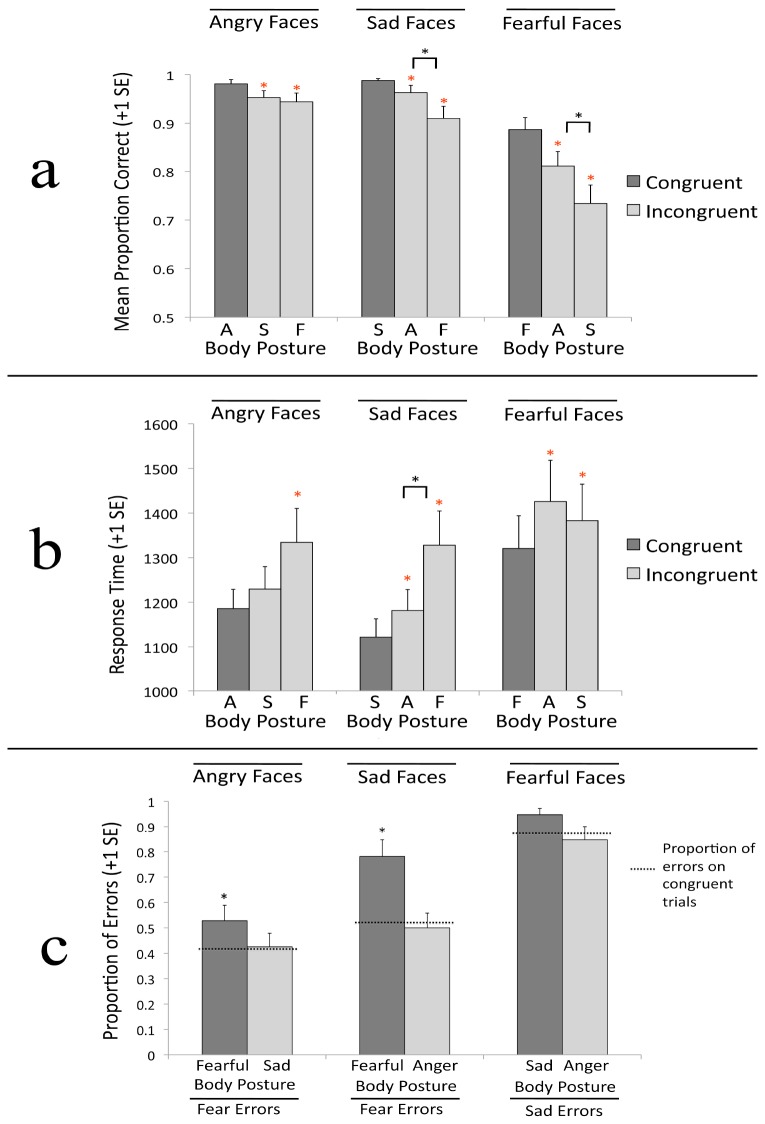
Results for Experiment 1a.a) Proportion of correct responses for each facial expression, presented by posture. b) Median reaction time results for each facial expression, presented by posture. Results are presented in milliseconds. c) Proportion of errors made for each facial expression, presented by posture. Dotted line represents the proportion of errors made by participants viewing congruent expressions, and was used as a baseline error level. * over individual bars indicate a significant difference between congruent and incongruent trials.